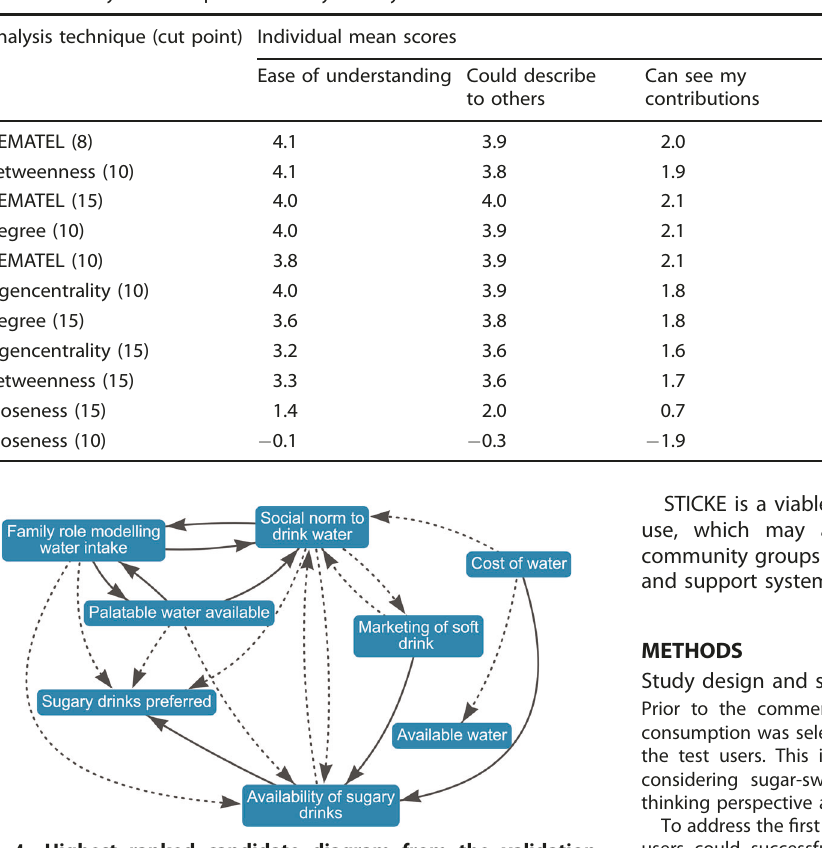
Fig. 4 Highest ranked candidate diagram from the validation survey. This diagram shows the set of variables and connections remaining after pruning the merged diagram according to the DEMATEL ranking, with an eight-variable cut point. This map was endorsed most strongly by the users in the validation